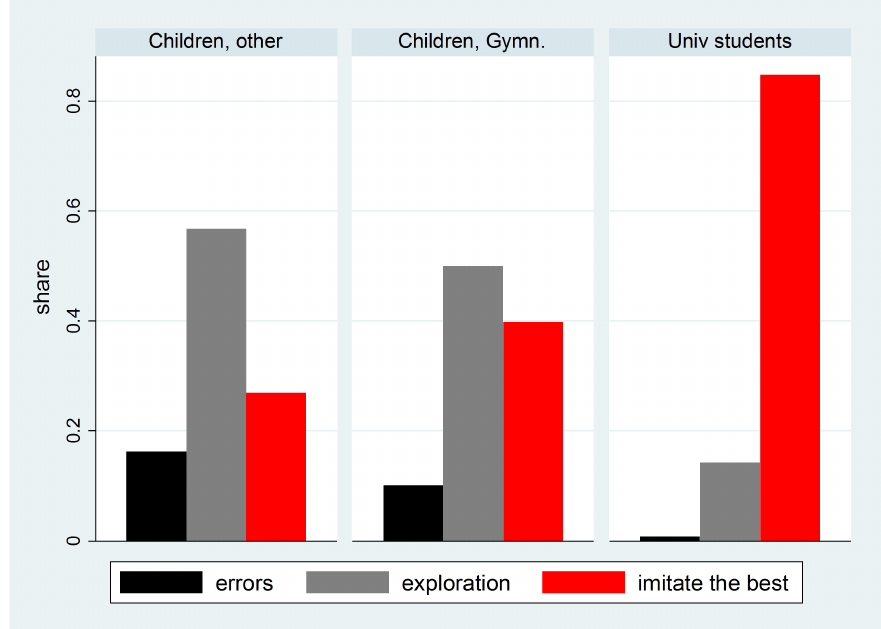
Figure 5. Share of choices that are compatible with errors, exploration, and “imitate-the-best”.